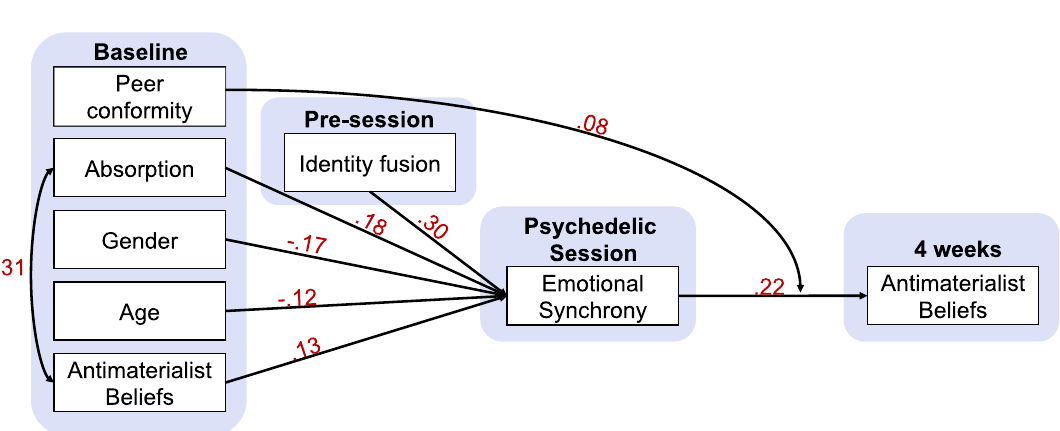
Figure 4. Changes in non-physicalist beliefs are moderated by baseline variables and pre-state identify fusion and mediated by acute emotional synchrony during the psychedelic session. Path model showing changes in Non-physicalist Beliefs to be affected by several demographic and trait characteristics including absorption, gender and age, mediated through perceived emotional synchrony during the psychedelic group session. The effect of synchrony on non-physicalist beliefs was conditional on respondents’ baseline scores of peer conformity. Standardized β-coefficients are shown for significant (p < 0.05) regression paths (not shown are additional significant correlations between non-physicalist beliefs at baseline and absorption with gender, r = 0.19 and r = 0.16, respectively, as well as a significant effect between beliefs at baseline and at 4 weeks post- session; β =